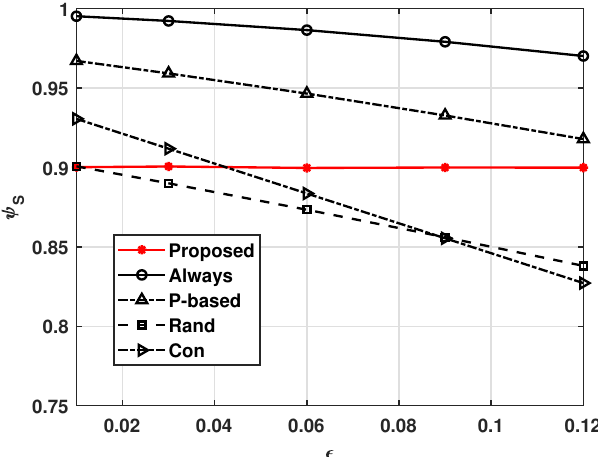
Figure 7. Average energy consumption ψ S versus (cid:101) Tx , where (cid:101) Rx =